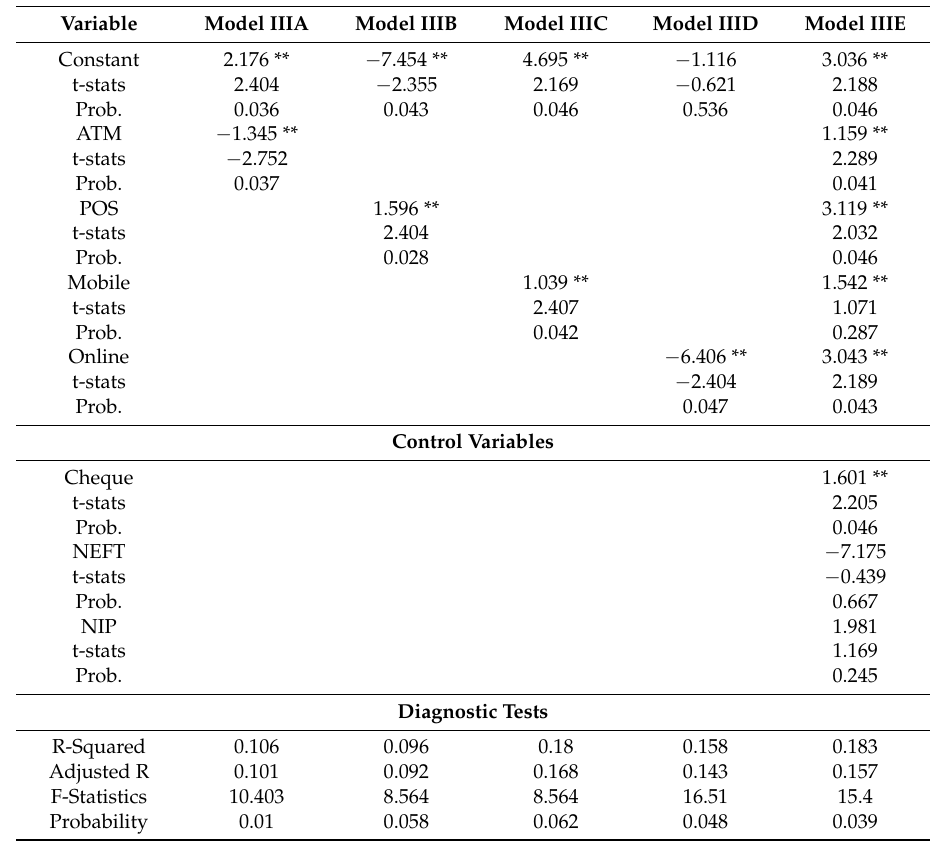
Table 7. Robustness Through Volume of Activities Model III (Dependent Variable: Risk